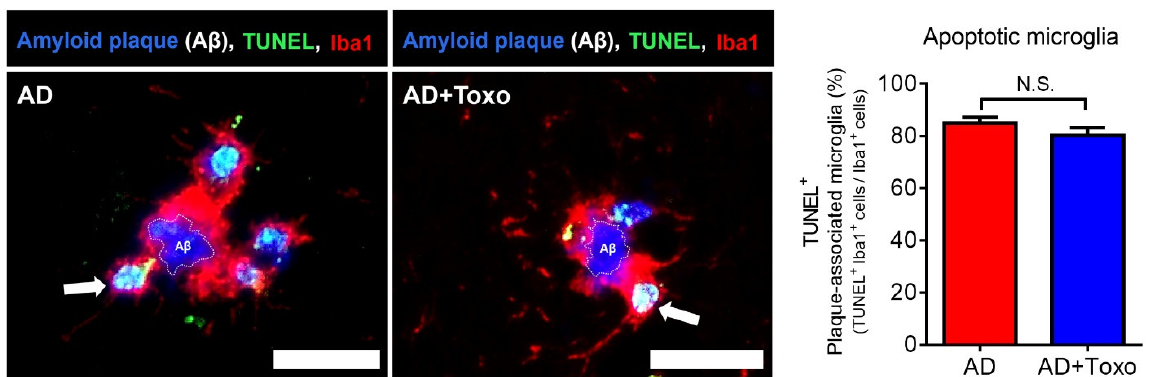
Figure 5. Apoptosis of plaque-associated microglia. TUNEL + -microglial cells surrounding the amyloid β (A β ) plaque. Arrows represent Iba1 and TUNEL double-positive cells (light blue). Number of Iba1 and TUNEL double-positive cells in plaque-associated microglia. The counting result of plaque-associated apoptotic microglia found around 60 amyloid plaques ((randomly selected 10 plaques per mouse) × 6 mice per group). Scale bar; 20 µ m. Data are represented as the mean ± SEM.